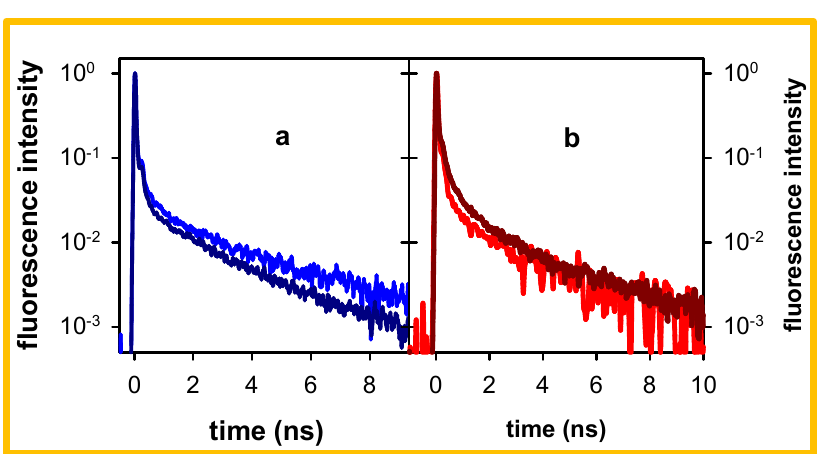
Figure 4. Normalized fluorescence decays recorded for pA • pT in standard buffer at 305 nm ( a ) and 420 nm ( b ) following excitation at 267 nm (blue, red) and 285 nm (dark blue, dark red). Table 1. Comparison of the % of photons emitted after 1 ns at 305 and 330 nm. Total time-range considered: −1–10.5 ns. Excitation wavelength: 285 nm.